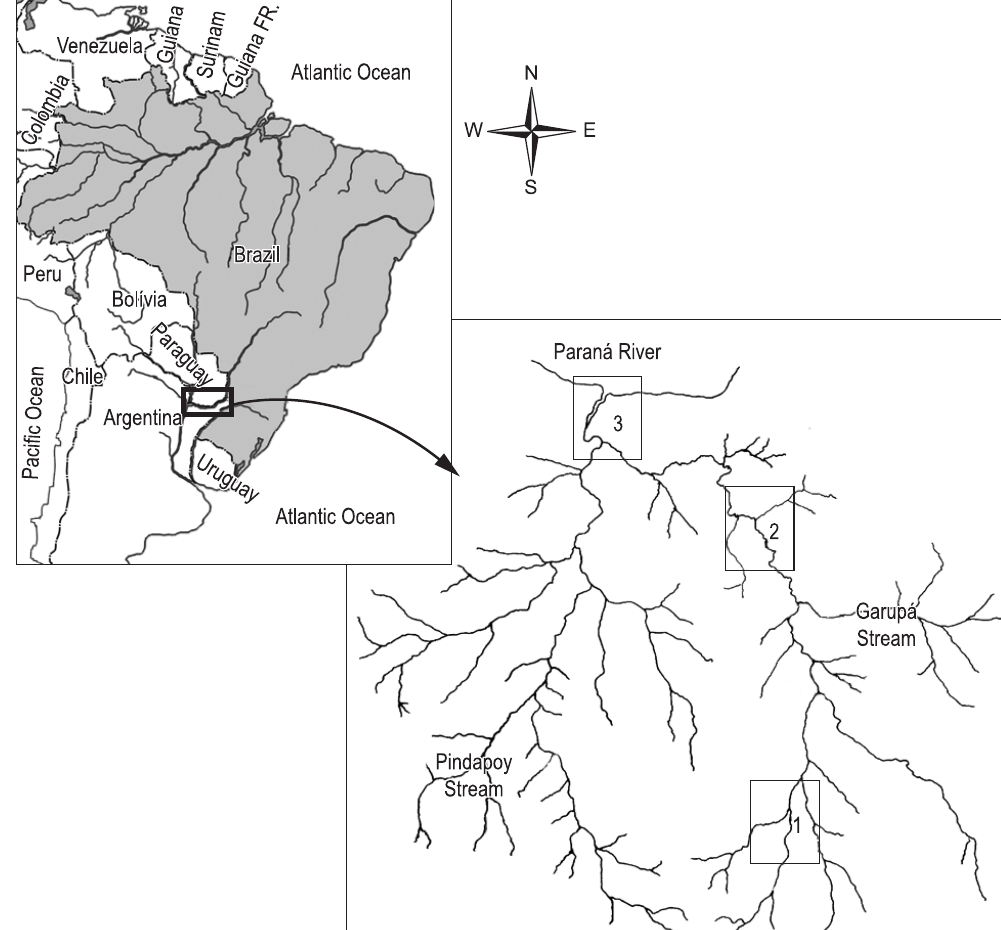
Figure 1. The study area with the sampling sites in Garupá Stream: 1) High Basin; 2) Middle Basin; and 3) Low